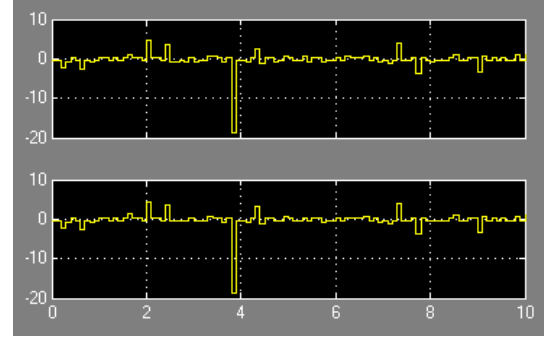
Figure 16. model with using ANN of Scope 3 ‘G 3 (u)’